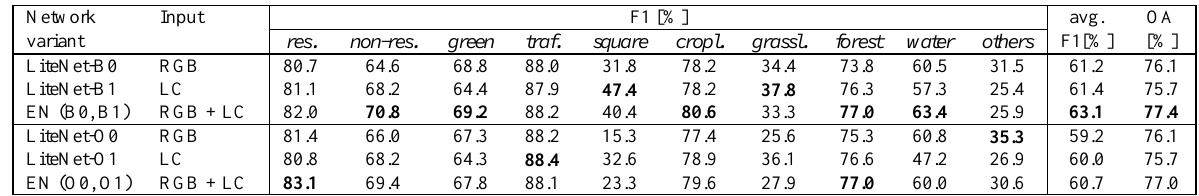
Table 2 : Results of land use classification. Network variant: cf. section 5.1.2. LC: Land cover. F1: F1 score, OA: Overall Accuracy, both evaluated on the basis of objects. Best scores are printed in bold